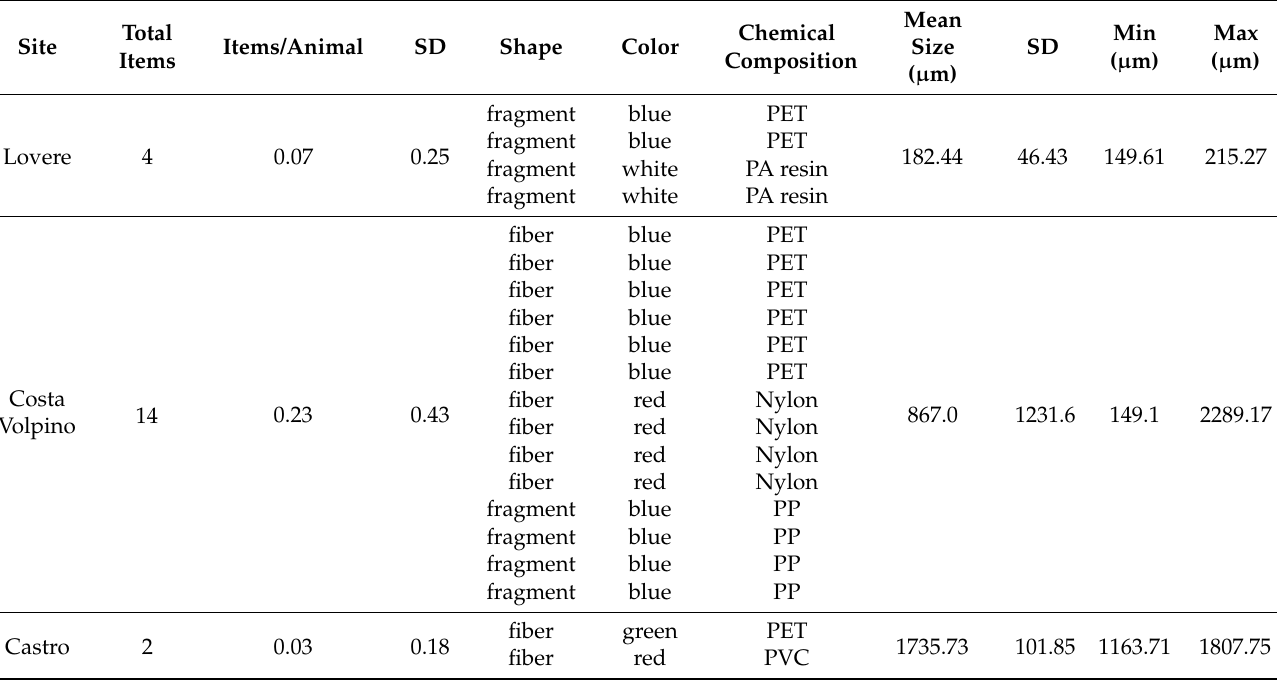
Table 3. Microplastics measured in Dreissena polymorpha at the three sampling sites reported as total items, items/animal, and standard deviation ( ± SD), shape, color, chemical composition, and range (min-max). PET denotes polyethylene terephthalate; PP, polypropylene; PA, resin polyamide resin; PVC, polyvinyl chloride.